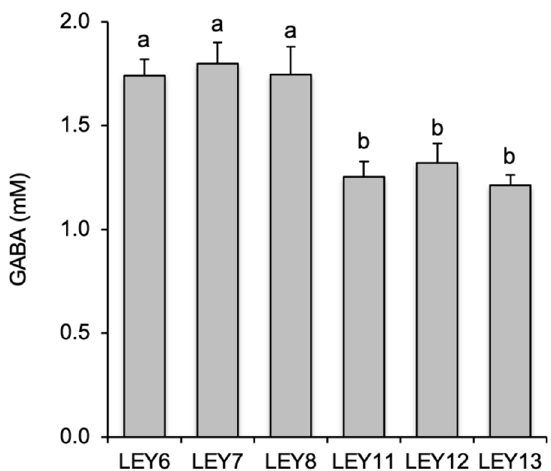
Figure 1. Production of γ -aminobutyric acid (GABA) by L. lactis isolates grown in GM17 supple- mented with 5 mM of monosodium glutamate for 5 days. Supernatants were analyzed by ultra-high performance liquid chromatography (UHPLC) to determine the GABA concentration of the extracellular medium. Bars with different letters indicate significant differences ( p < 0.05).